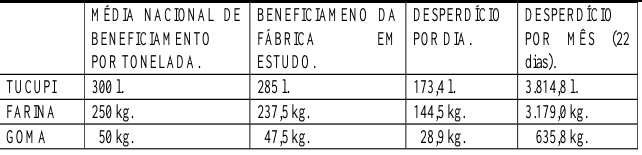
Fonte: Adaptada de EMBRAPA,